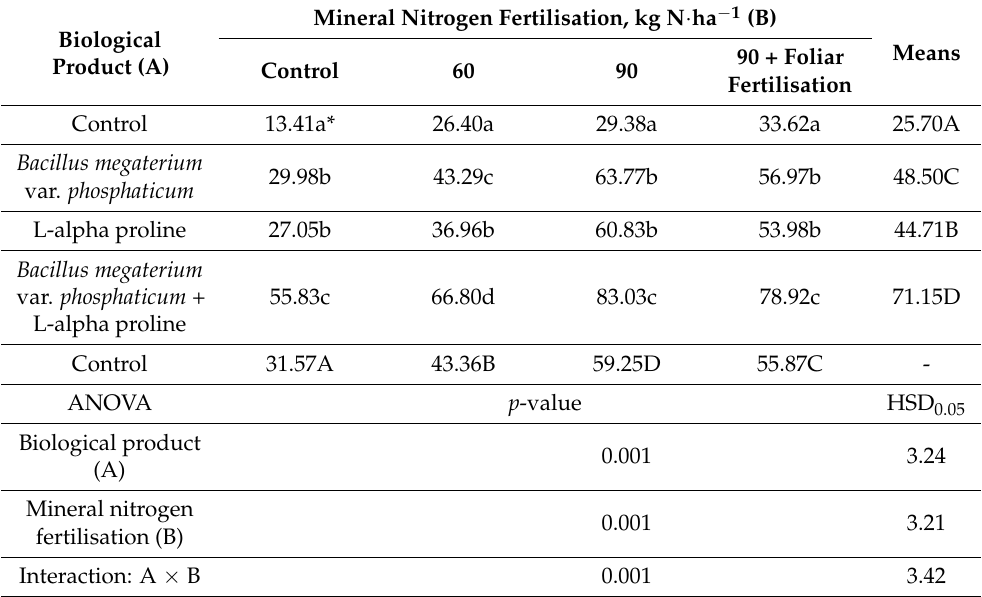
Table 9. Fe uptake by spring wheat straw (means across 2017–2019), g · ha − 1